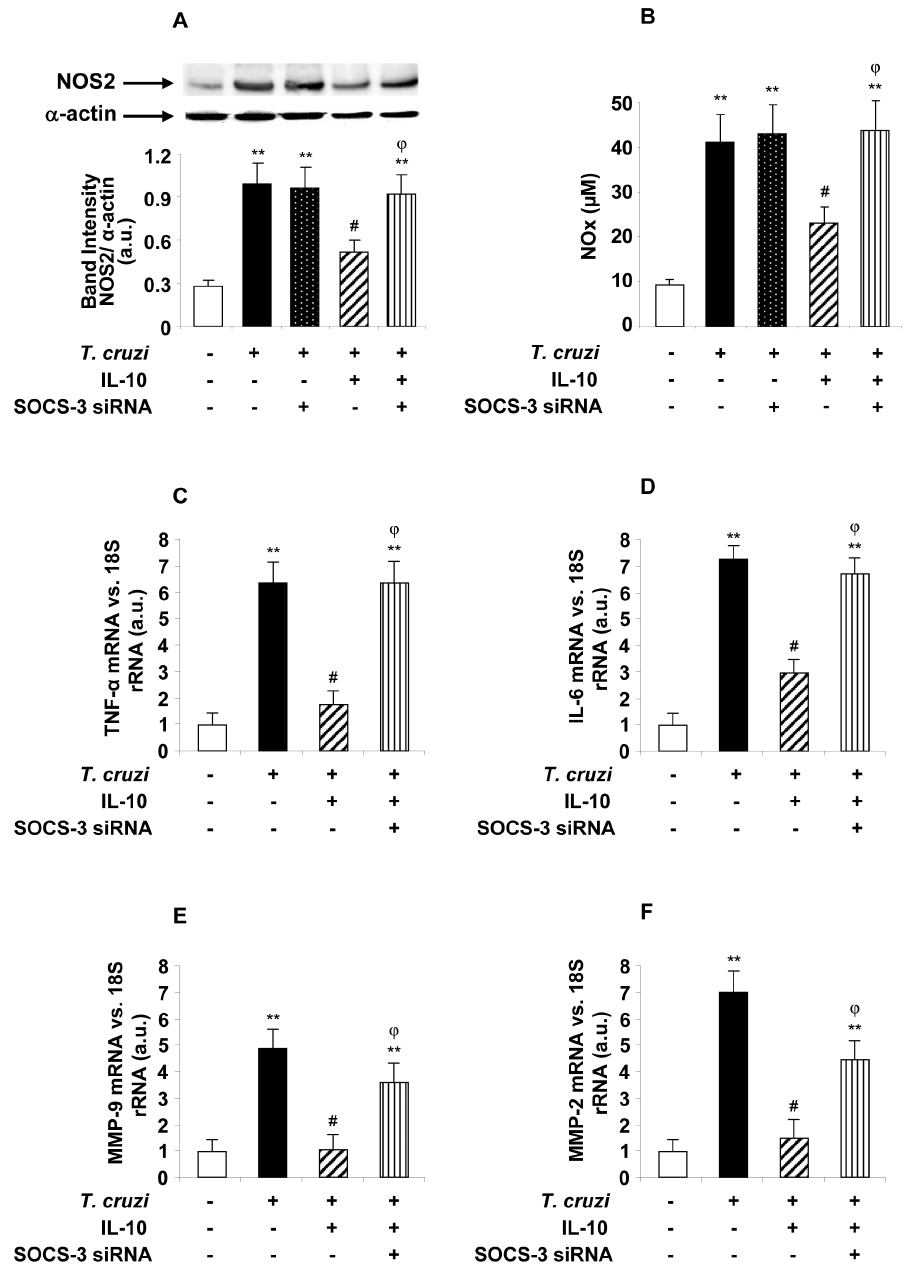
Figure 6. SOCS-3 is involved in the anti-inflammatory effects exerted by IL-10. Cardiomyocytes were pre-treated with 20 ng/ml of IL-10, infected with T. cruzi or transfected with SOCS-3 siRNA for 72 h, pre-treated with IL-10 and infected for 48 h. (A) NOS2 expression levels were determined by Wb. (B) In the same conditions NOS2 activity was evaluated by quantification of NO levels by Griess reaction in the culture media. (C) and (D) TNF- a and IL-6 mRNA levels were analysed by Q-RT-PCR in the same conditions but only for 4 h post infection. (E) and (F) In the same conditions as in (A), MMP-9 and MMP-2 mRNA levels were analysed by Q-RT-PCR. For A, results show the mean 6 SD (n=3) and protein levels were normalized against a -actin. In B, results are expressed as mean 6 SD (n=3). In C,D,E and F, the results were normalized against 18S and represent the mean 6 SD of three independent experiments **p , 0.01 vs. control cells; # p , 0.05 vs. T. cruzi infected cells; Q p , 0.05 vs. T. cruzi infected + IL-10 treated